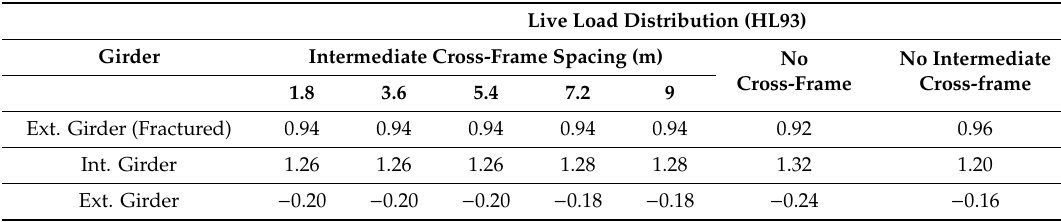
Table 3. Live load distribution under HL93